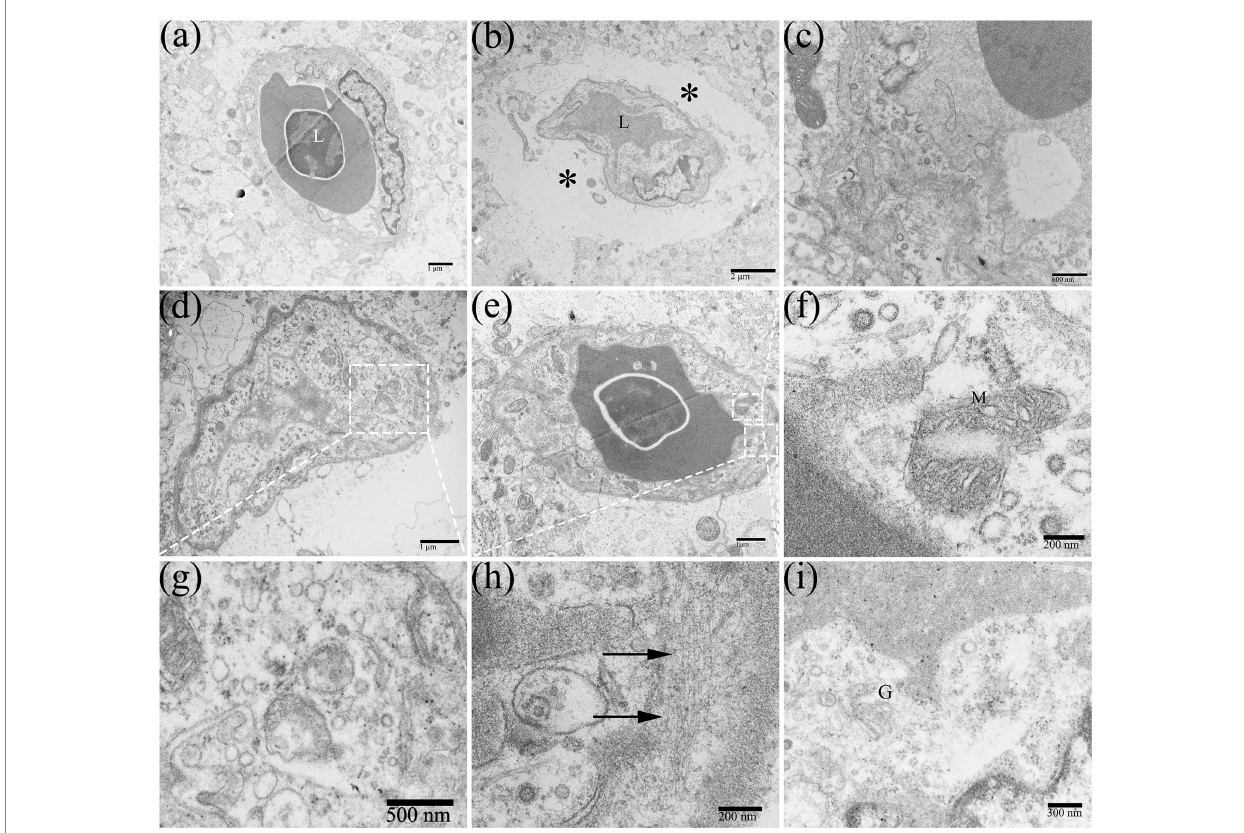
FIGURE 8 Edema around the capillaries in the duckling brains. (A) Normal brain capillary. (B) Edema around capillaries ( * ). (C) Disorders of the capillary structure. (D,G) Pinocytosis vesicles were abundant in capillaries. (E,F,H,I) Ultrastructural cytoplasmic changes in brain microvascular endothelial cells (BMECs), such as mitochondrial destruction, increased microfilaments (arrow), and the slightly swollen Golgi apparatus. L, lumen; M, mitochondrion; and G, golgi apparatus.